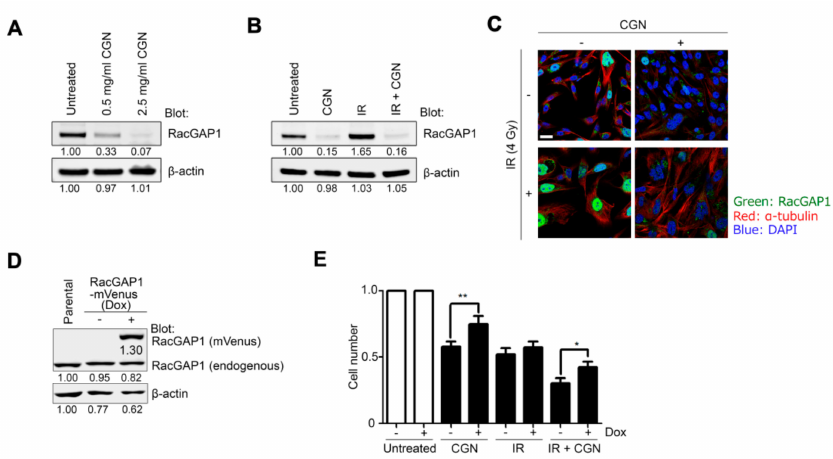
Figure 5. RacGAP1 expression is suppressed by CGN in MDA-MB-231 cells. ( A ) Protein expression of RacGAP1 was analyzed after treatment with di ff erent concentrations of CGN in MDA-MB-231 cells. Total cell lysates were subjected to western blot. ( B ) RacGAP1 protein expression was analyzed using cell lysates after IR and / or CGN treatment in MDA-MB-231 cells. ( C ) Immunofluorescence images show RacGAP1 (green), α -tubulin (red) and nuclei (blue). Bar, 25 µ m. ( D ) RacGAP1-mVenus expression was induced by doxycycline in MDA-MB-231 cells. RacGAP1 expression was analyzed by western blot using anti-RacGAP1 antibody. Dox, doxycycline. ( E ) Cell number was quantified by cell counting. Columns, mean ( n = 3); bars, SE. *, p < 0.05; **, p < 0.01. For the continuous full length-image of Western blot signals, please refer to Supplementary Materials Figure